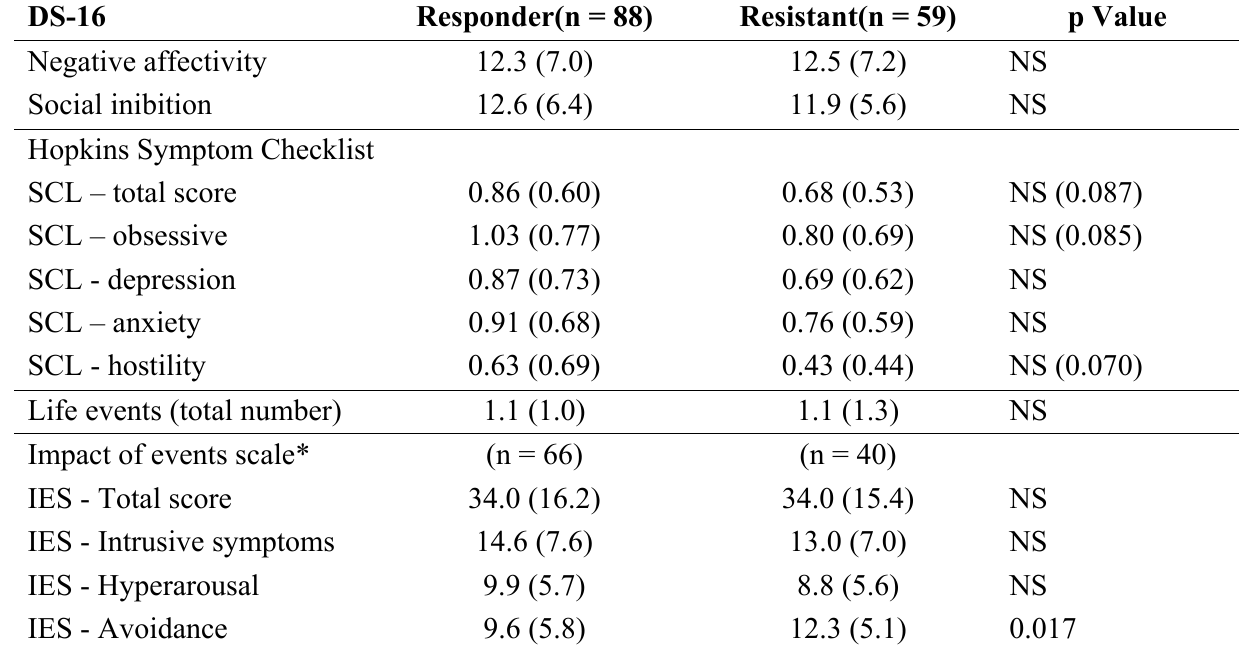
Table 2. Psychological characteristics of “responder” and “resistant”